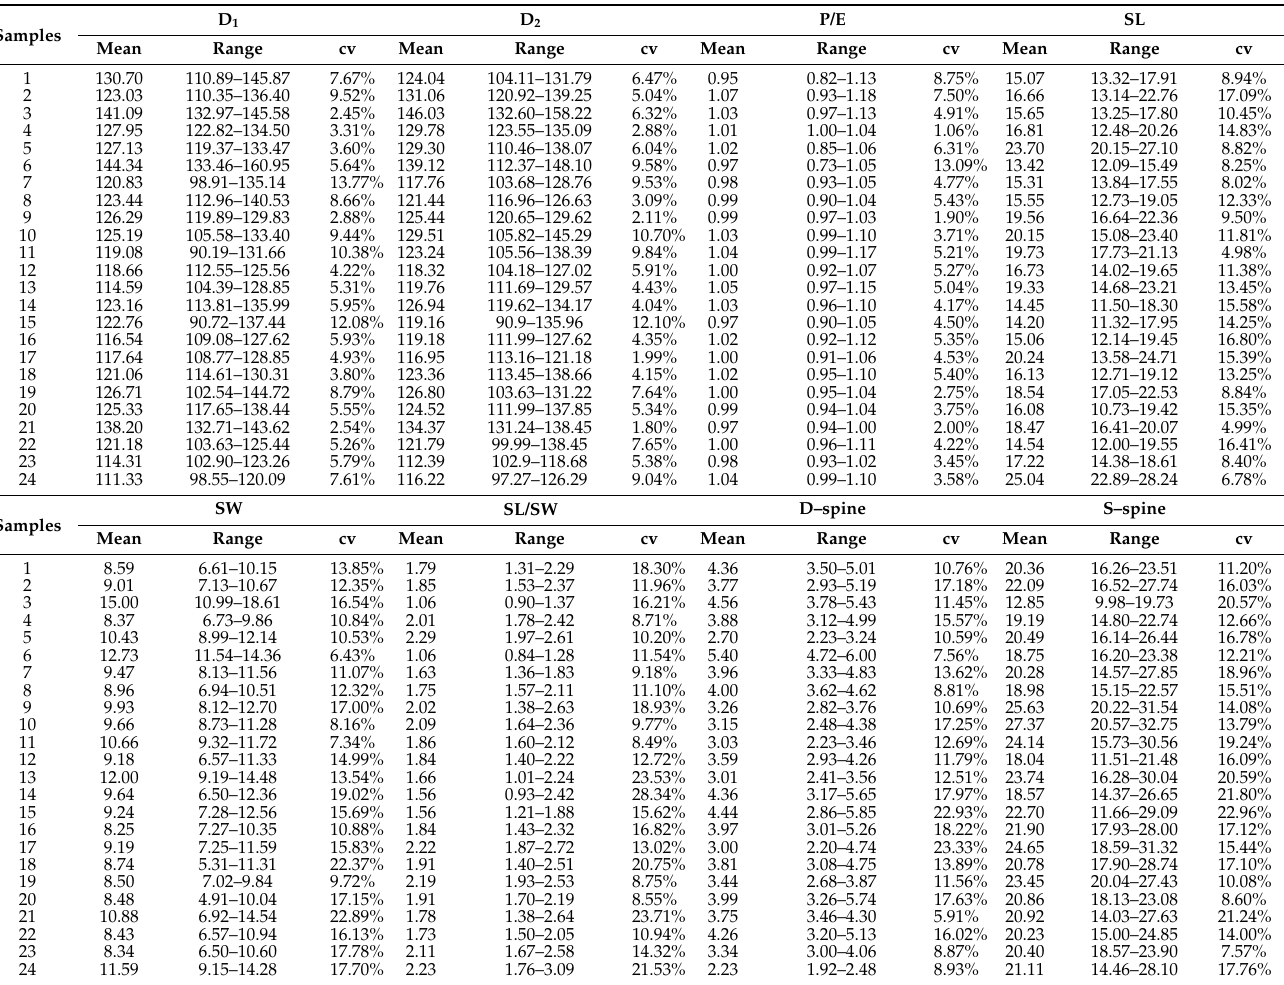
Table A1. The minimal, maximal, mean values and coefficient of variation (cv) for eight quantitative pollen traits of Hibiscus syriacus .